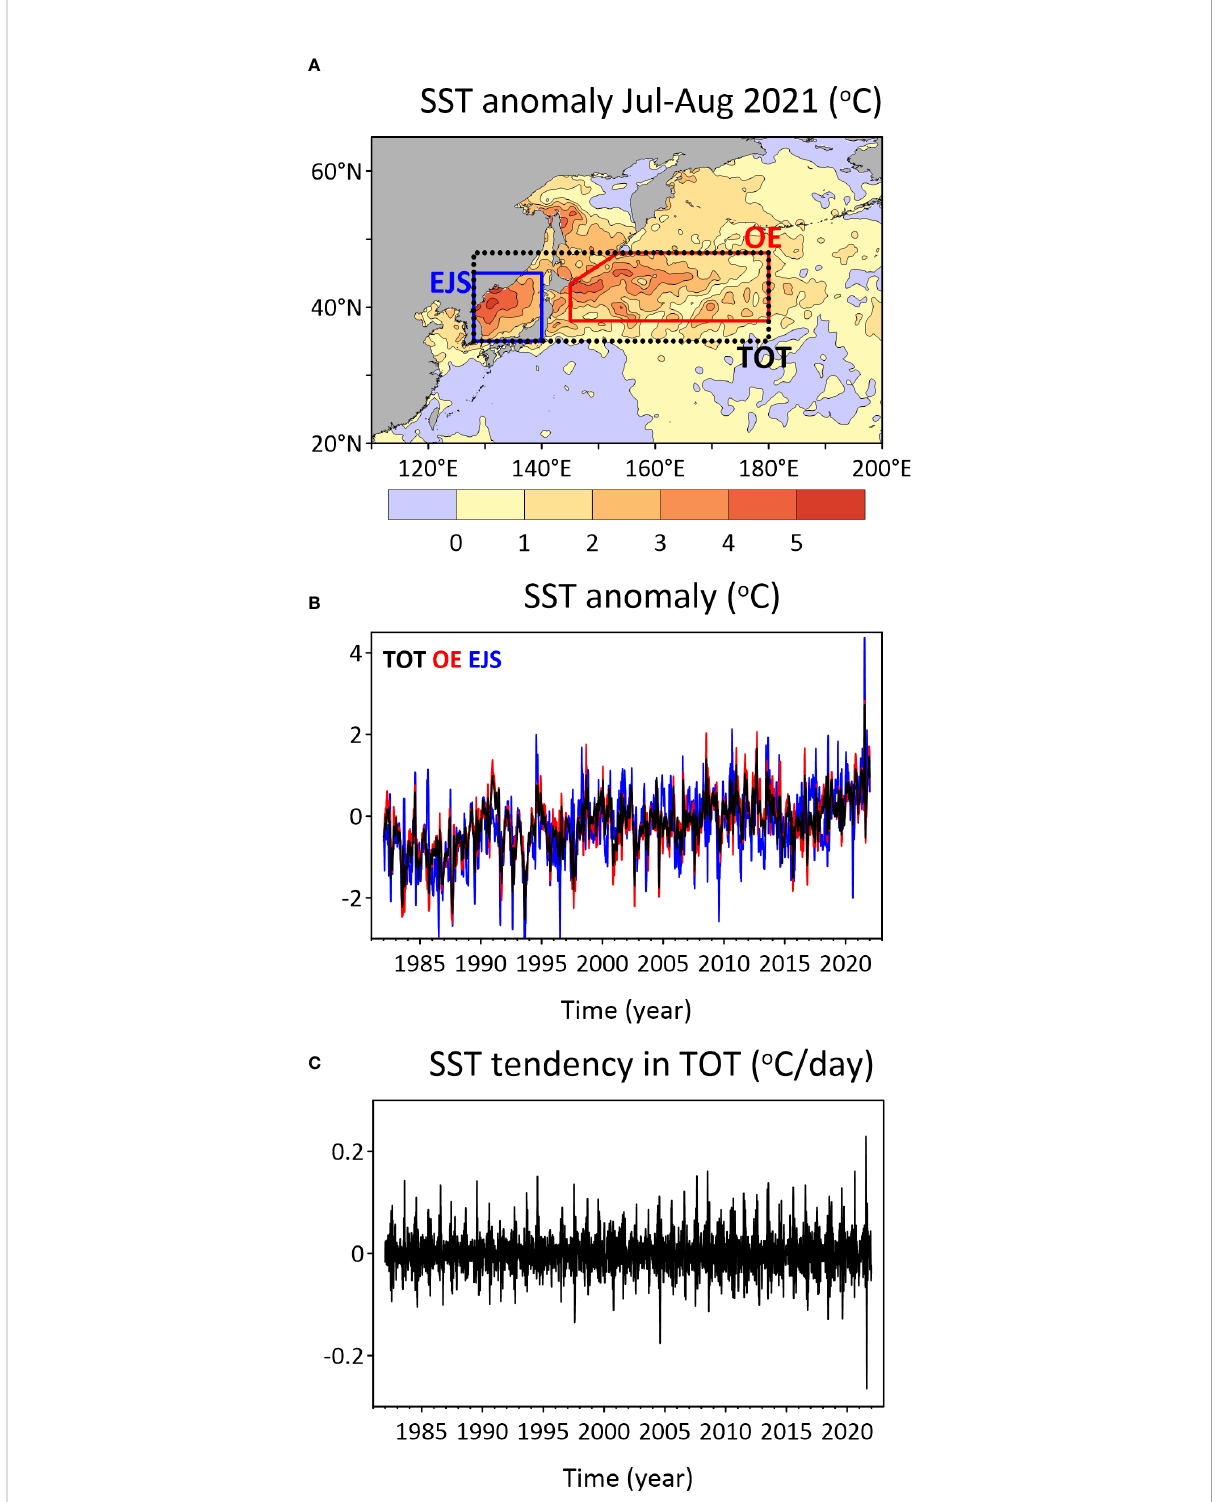
FIGURE 1 (A) Spatial map depicting the distribution of the sea surface temperature (SST) anomaly during July 16 – August 15 2021, relative to the climatology of 2001 – 2020, overlaying with the total (TOT) mid-latitude in the western North Paci fi c (black dotted box), Oyashio Extension (OE; red box), and East/Japan Sea (EJS; blue box) regions. (B) Time series of the 11-day moving average of the SST anomaly in TOT (black), OE (red), and EJS (blue) regions. (C) Time series of SST tendency obtained from the 11-day moving average of the SST in